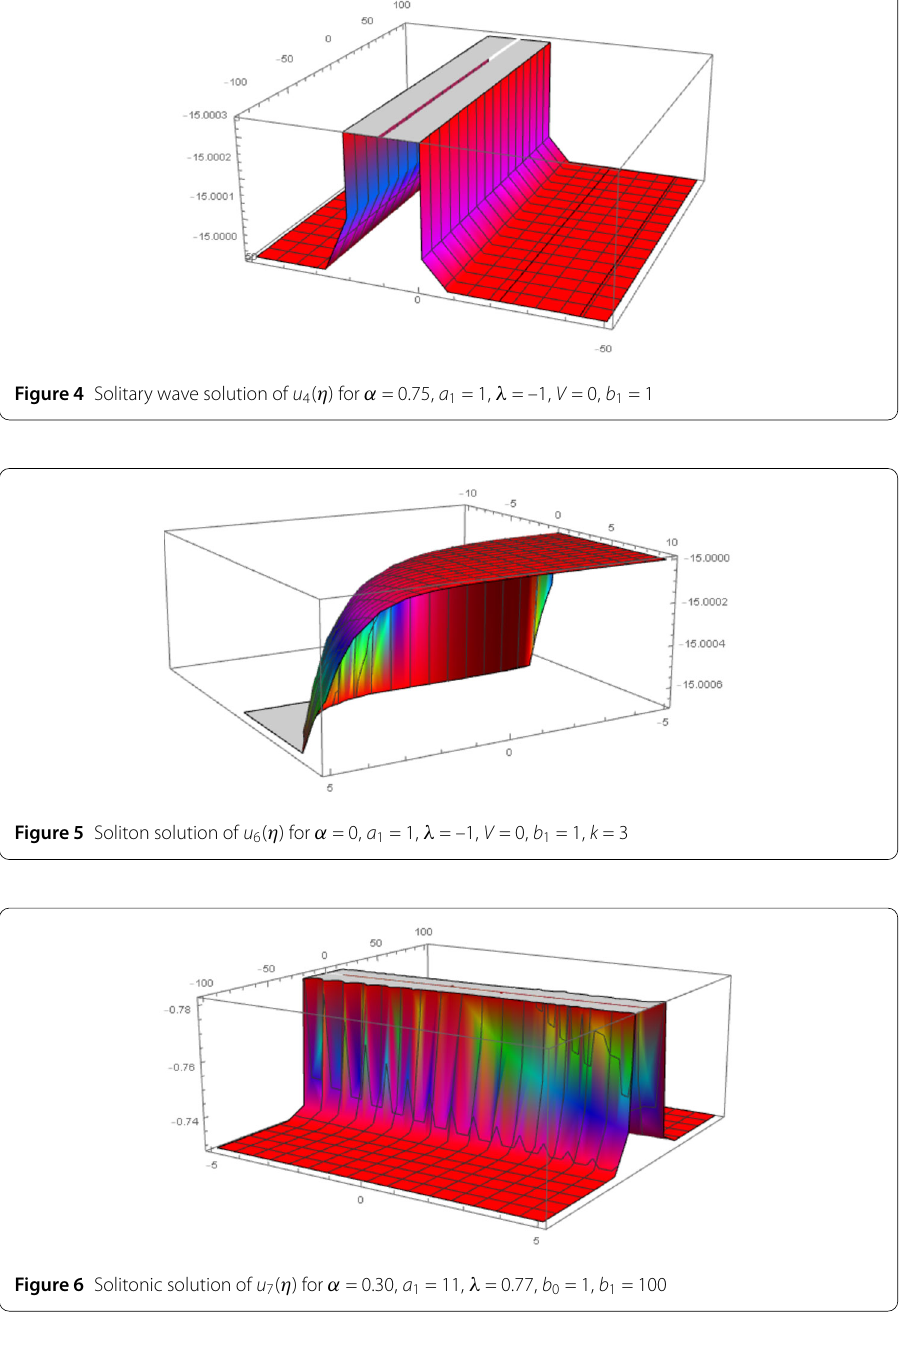
that are periodic. Finally, Fig. 9 represents the periodic solution of u 19 ( η ) for α = 0.30, a 1 = 11, λ = 0.77, b 0 = 1, V = 10, b 1 = 100. Figure 10 shows the soliton solution of u 16 ( η ) for the choice of α = 0.25, a 0 = 0.5, λ = –1, V = 0.1, b 0 = 2, k = 3. Kink wave solution is obtained in Fig. 11 of u 14 ( η ) for α = 0.9, a 0 = 0.5, λ = –1, V = 0.1, b 0 = 11, k = 3. Figure 12 displays the periodic solution of u 15 ( η ) for different values of α = 0.1, a 1 1 = 11, λ = 3, V = 12, b 0 = 1, b 1 = 3. Finally in Fig. 13 we have found solitonic solution of u 19 ( η ) for α = 0.25, k = 5, V = 12, a 1 = 1, b 1 =